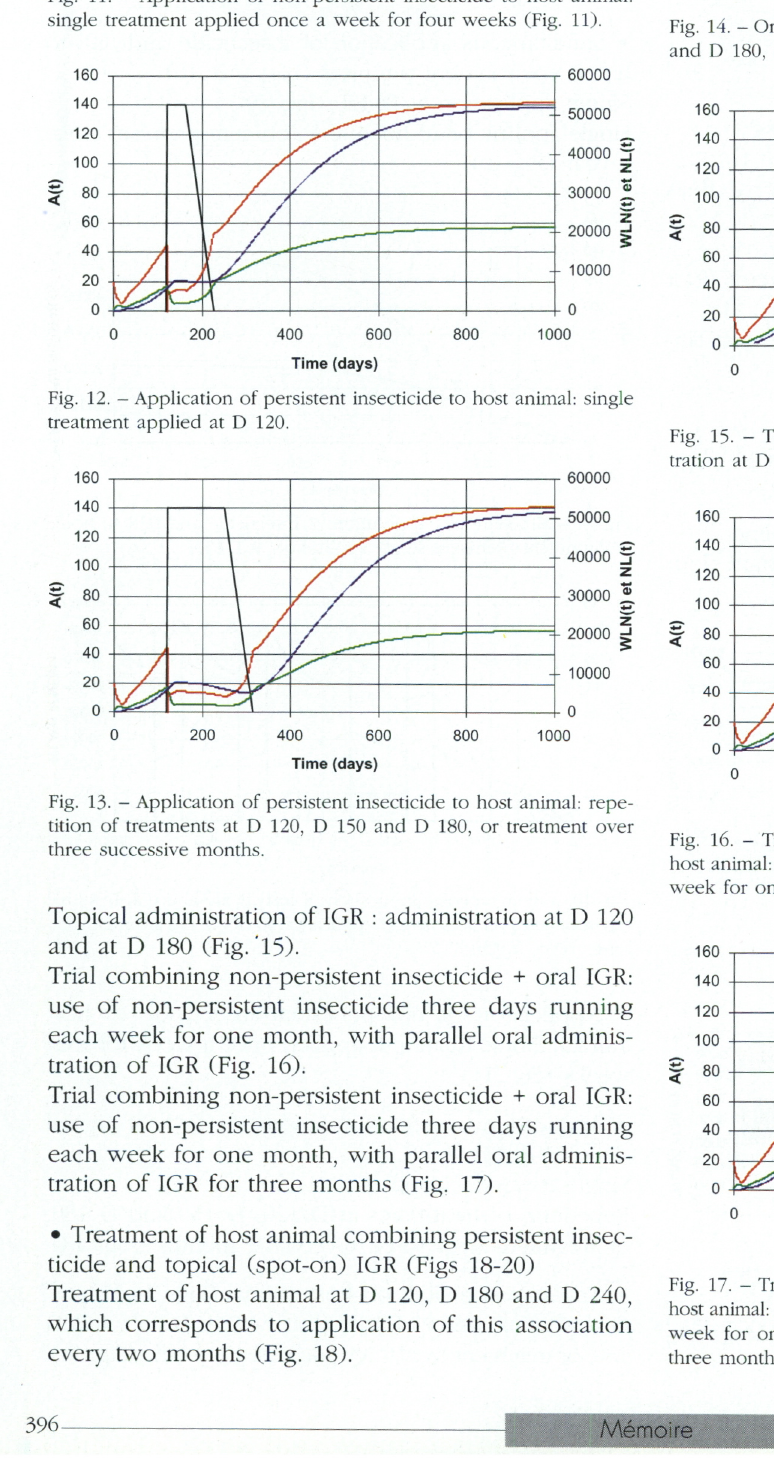
Fig. 11. - Application of non-persistent insecticide to host animal: single treatment applied once a week for four weeks (Fig. 11).